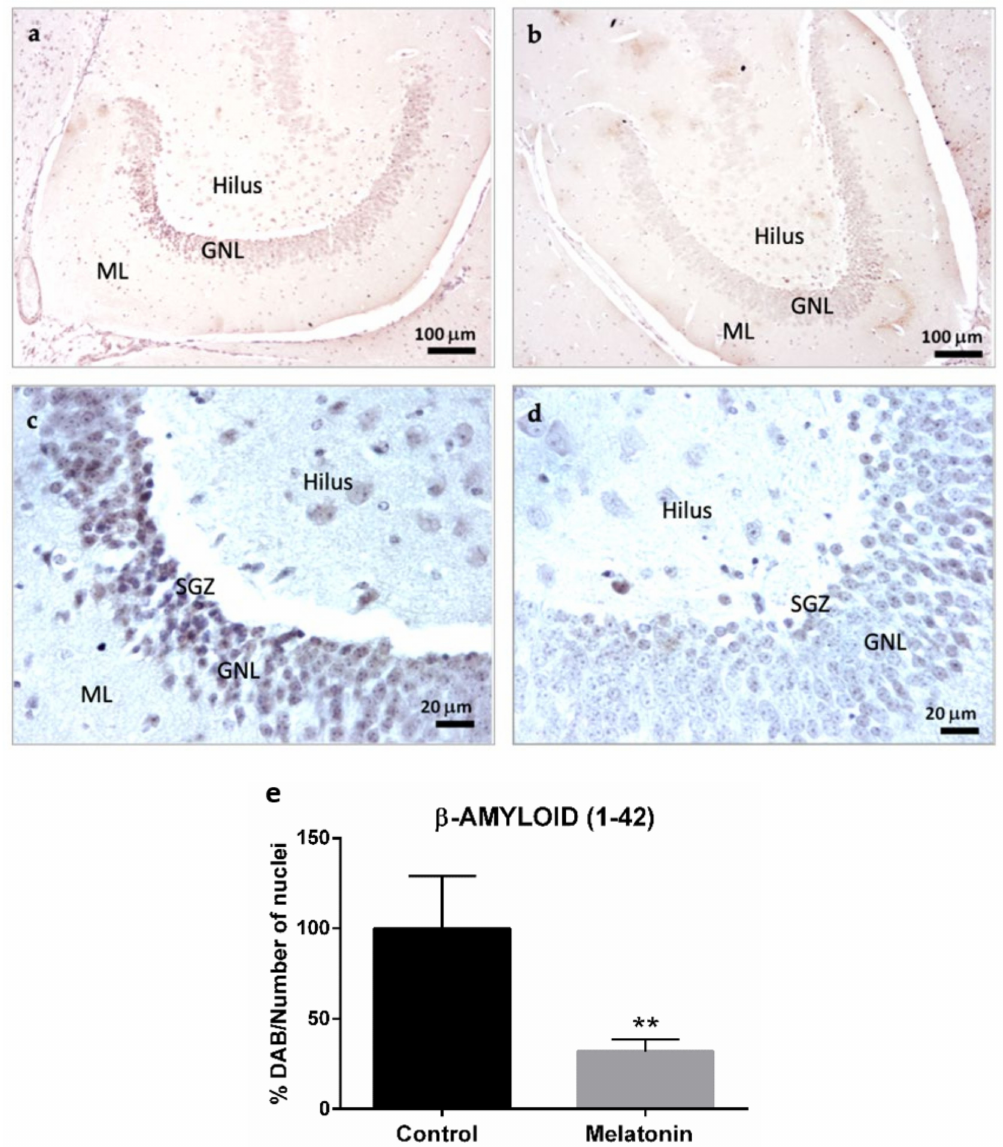
Figure 3. β -Amyloid (1-42) immunostaining in the hippocampal dentate gyrus of SAMP8 control mice ( a , c ) and SAMP8 mice treated with melatonin ( b , d ). Bar chart ( e ) shows quantification of the DAB signal with respect to the total number of nuclei at 400 × magnifications (in percentages with respect to the control). Data are expressed as means ± SEM. ** p < 0.01 vs. control. ML, the molecular layer; GNL, the granule neurons layer; SGZ, the subgranular zone. Statistical analysis was always performed in 10 images obtained from each control mice ( n = 4) and mice treated with melatonin ( n =